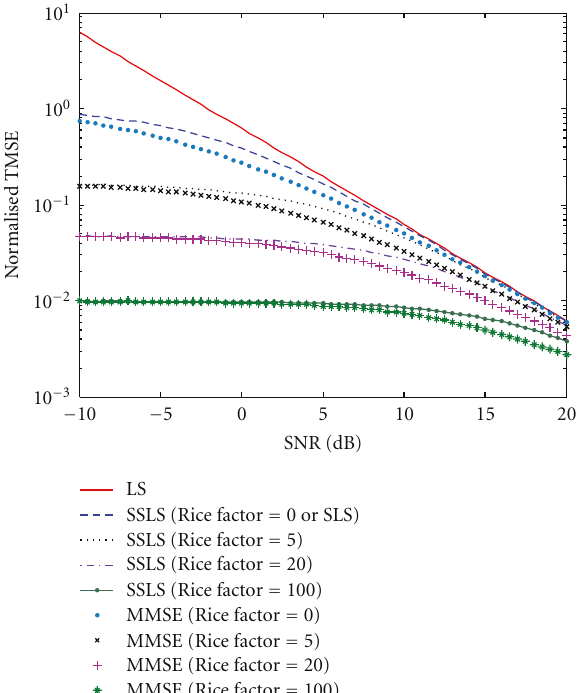
Figure 6: Normalized TMSEs of LS-based and MMSE estimators for various Rice factors in the case of L = 4, N T = N R = 2, N P = 20 .